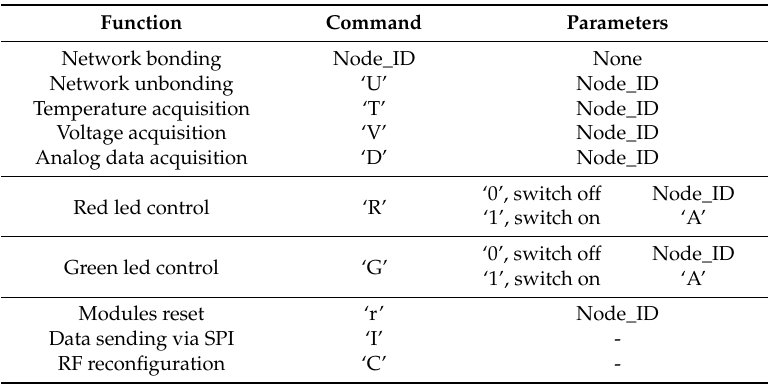
Table 2. Available commands to control the end nodes. SPI, Serial Peripheral